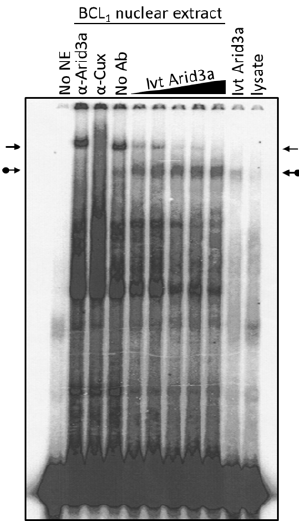
Figure 7. Arid3a over-expression abrogates NF- μ NR-DNA binding. BCL 1 nuclei were extracted and the extract was mixed with in vitro translated Arid3a before DNA binding. The mixture was subject to EMSA using Tx125 probe. The unmodified arrows indicate the NF- μ NR complex and the dotted arrows indicate the Arid3a complex.